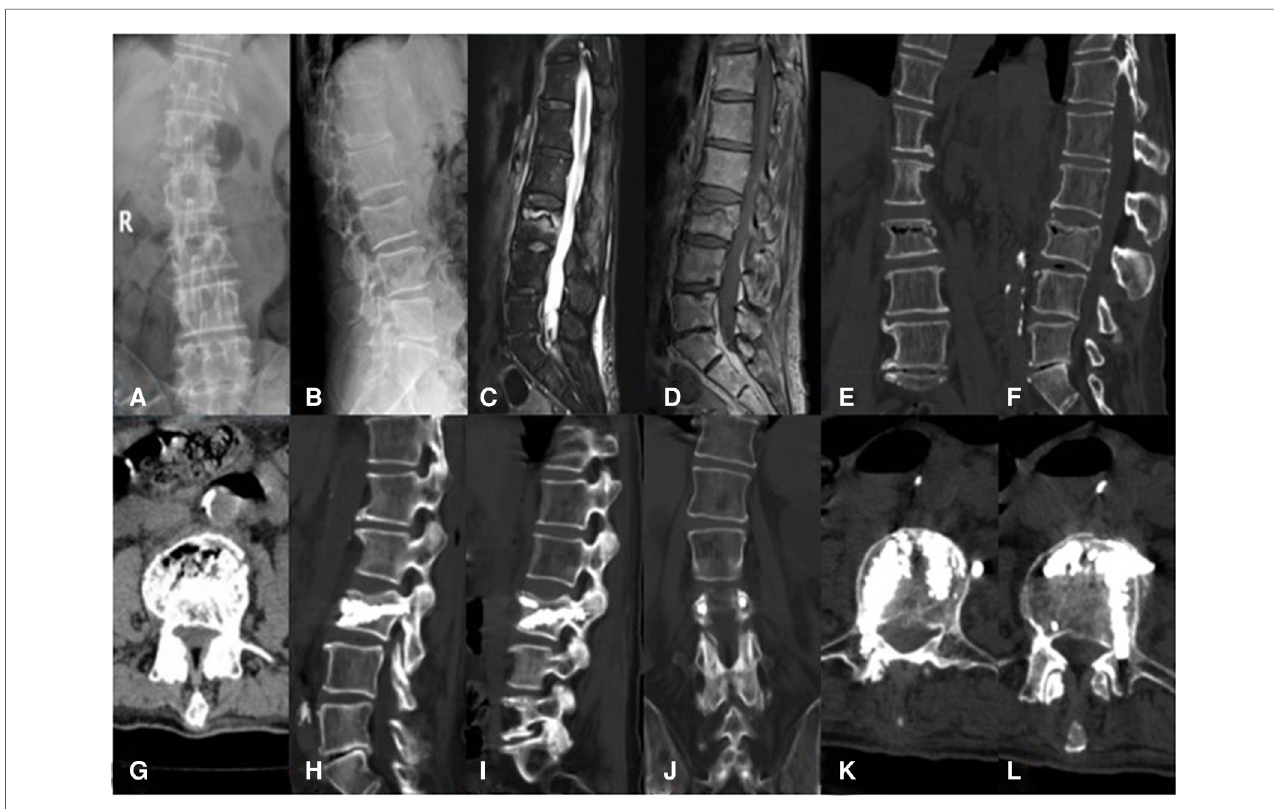
FIGURE 2 An 81-year-old male patient with KD at L3 treated using bilateral pedicle anchoring technique with PVP: ( A,B ) preoperative radiographic images; ( C ) the sagittal T2-weighted MR image showing high signal intensity in the cleft; ( D ) the sagittal T1-weighted MR image showing low signal intensity in the cleft; ( E – G ) CT scans showing the intravertebral vacuum sign; ( H,I ) CT scans after operation showing the bone-cement- fi lled cleft and vertebrae; ( J – L ) bone cement dispersion was observed in both pedicles. KD, Kümmell ’ s disease; PVP, percutaneous